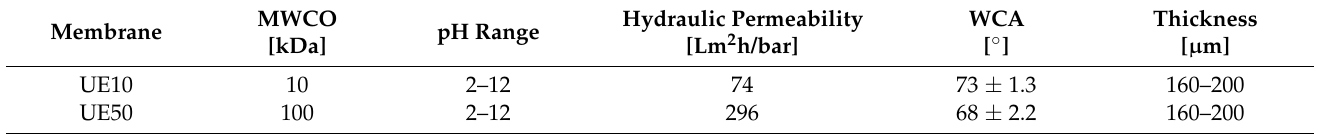
Table 1. Characteristics of ultrafiltration PES ultrafiltration membranes used in the present